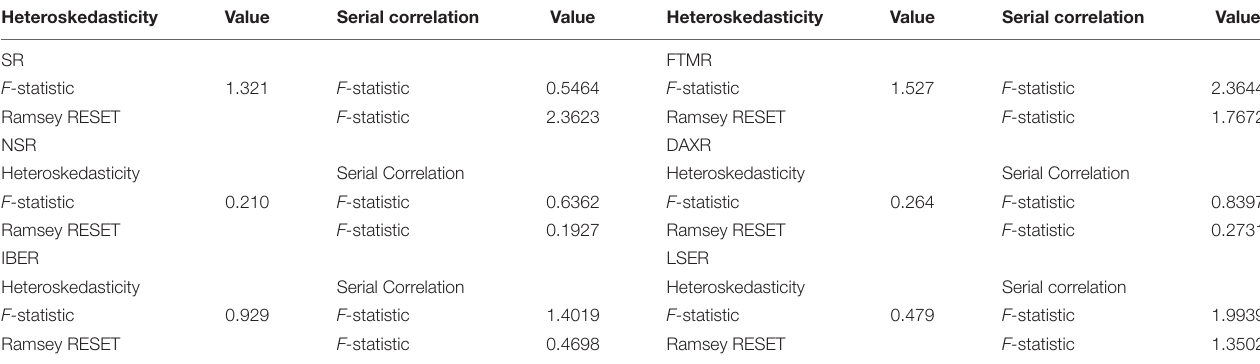
TABLE 11 | Diagnostic test results.